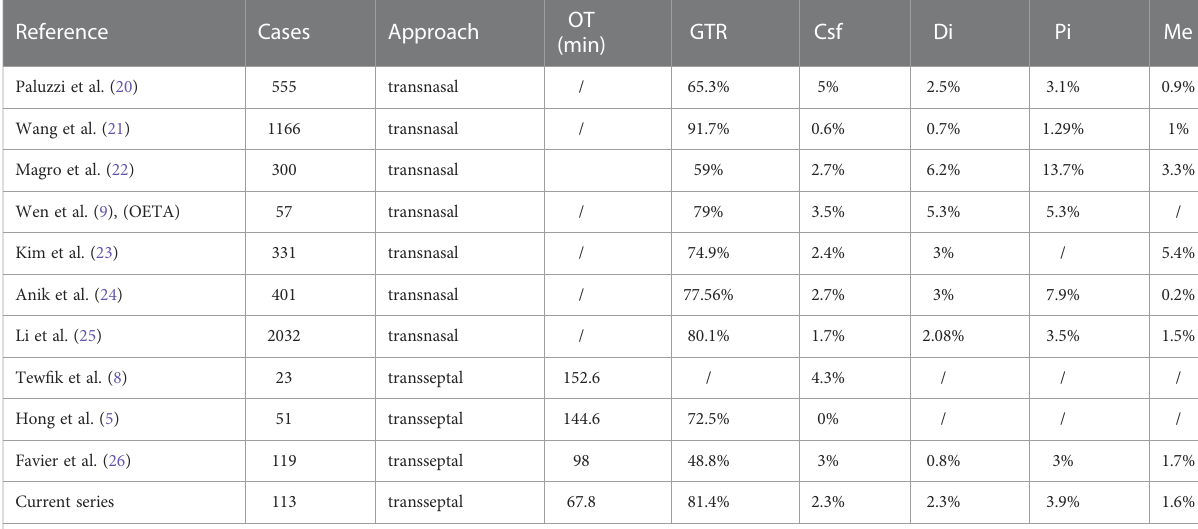
TABLE 4 Overview of surgical outcomes of published pituitary adenoma surgery.